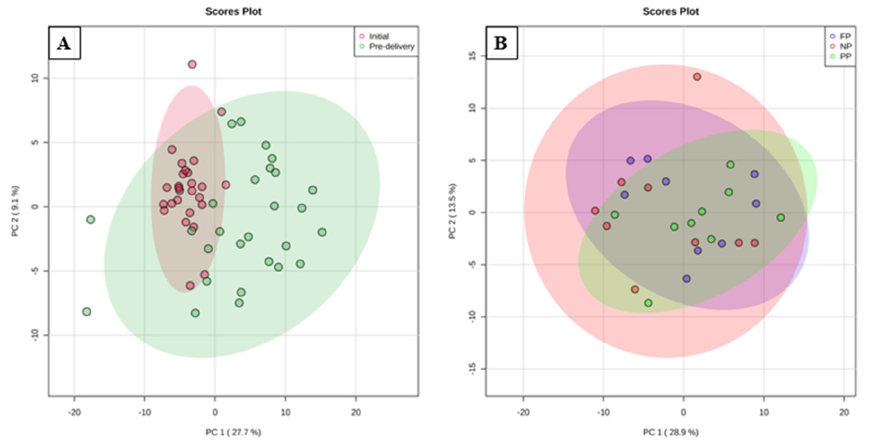
Figure 1. Principal component analysis (PCA) scores plot of metabolome distribution of plasma of dams between the times (( A ) initial and pre-delivery) and between the nutritional treatments in pre-delivery period (( B ) NP, PP and FP).